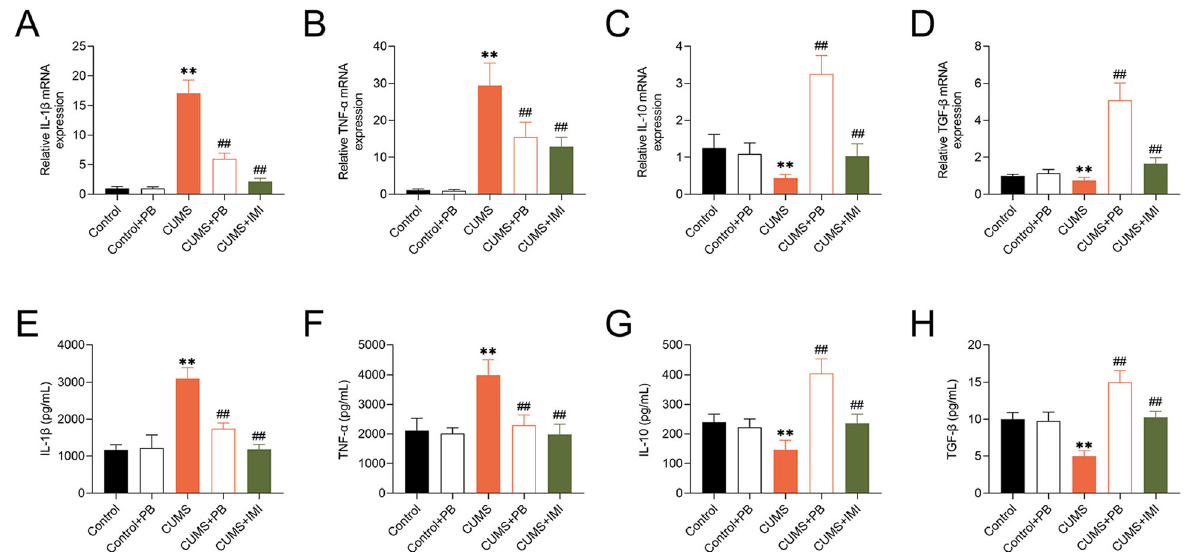
Fig. 5 PB regulated inflammatory factors expression in CUMS mice B The expression of IL-1 β , TNF- α , IL-10 and TGF- β in mice were determined by qRT-PCR. b The concentrations of IL-1 β , TNF- α , IL-10 and TGF- β in hippocampus of mice were detected by ELISA assay. ** p < 0.01 vs. Control. ## p < 0.01 vs.